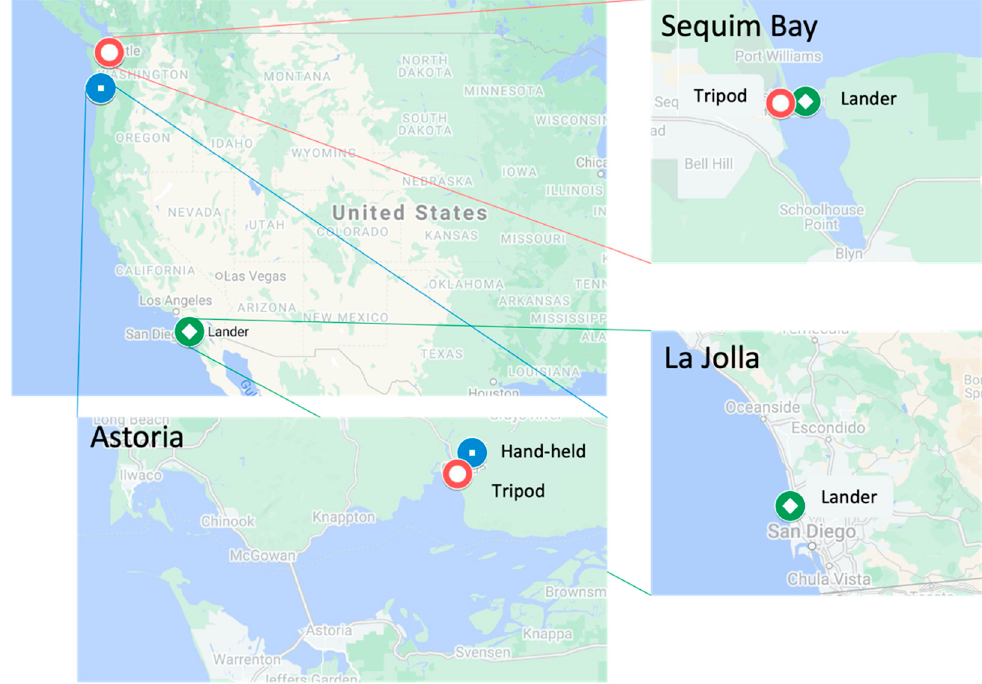
Figure 3. U.S. west coast deployment locations of the Boxfish camera in the hand-held, tripod, and lander configurations.